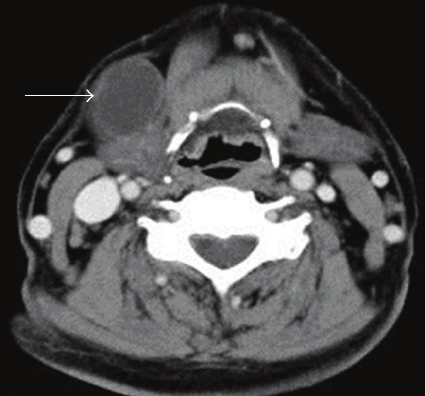
Figure 2: Contrast-enhanced CT (axial view). The cystic lesion was located anterior to the submandibular gland under the platysma and the margin of the mass was enhanced, suggesting a cystic lesion (arrow).